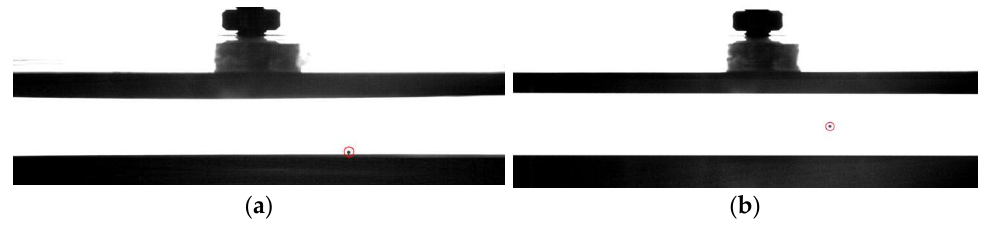
Figure 9. ( a ) The picture of the static particle ( b ) The picture of the lifting particle. The lifting voltage of particles with different ageing times was tested. The results show that the lifting voltage was 12.42 kV when the test was carried out on the bare elec- trode. To ensure the reliability of the experimental results, multiple groups of experiments were carried out on samples with different ageing degrees. The experimental results are shown in Figure 10. When the surface of the electrode was coated with epoxy resin, the lifting voltage increased to 18.12 kV, which is about 45.89% higher than that of the bare electrode. With the increase in ageing time, the inhibitory effect of the coating on particles decreased gradually. When the ageing time reached 1200 h, the particle-lifting voltage was about 16.86 kv. Although the lifting voltage decreased, it was still significantly higher than that of the bare electrode, which was about 35.7%, indicating that the ageing coating still had an obvious inhibitory effect on the movement of particles.